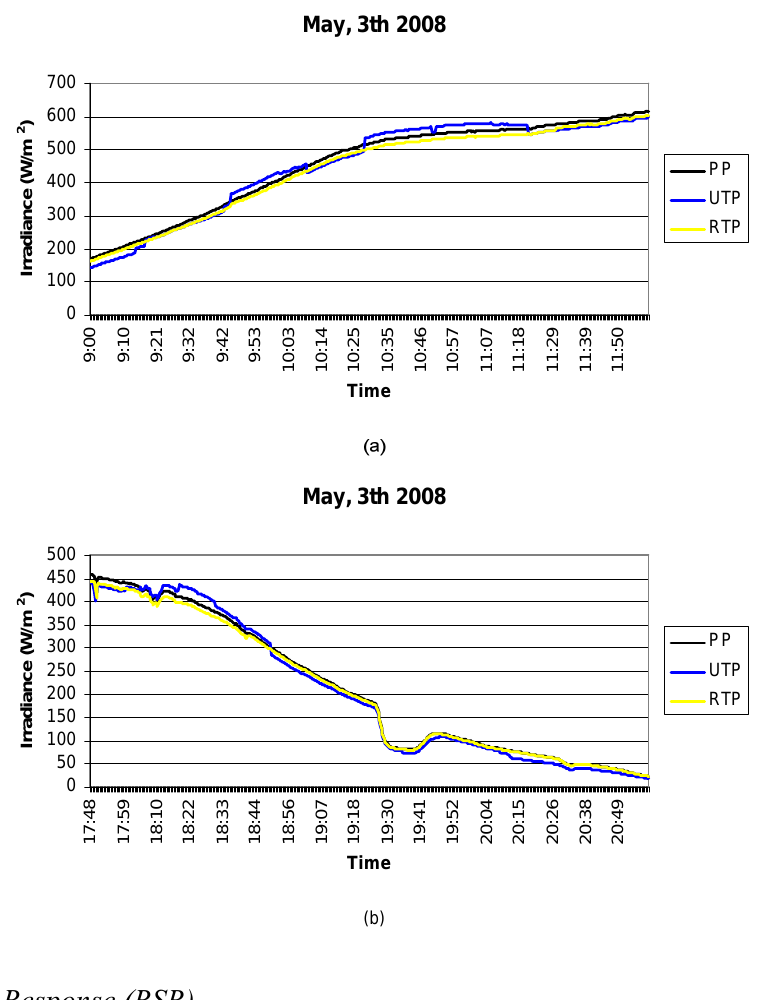
Figure 10. (a)-(b) . Detail of the irradiance measurements from the 3 rd May 2008. In it the inferior performance of the UTP against the RTP can be